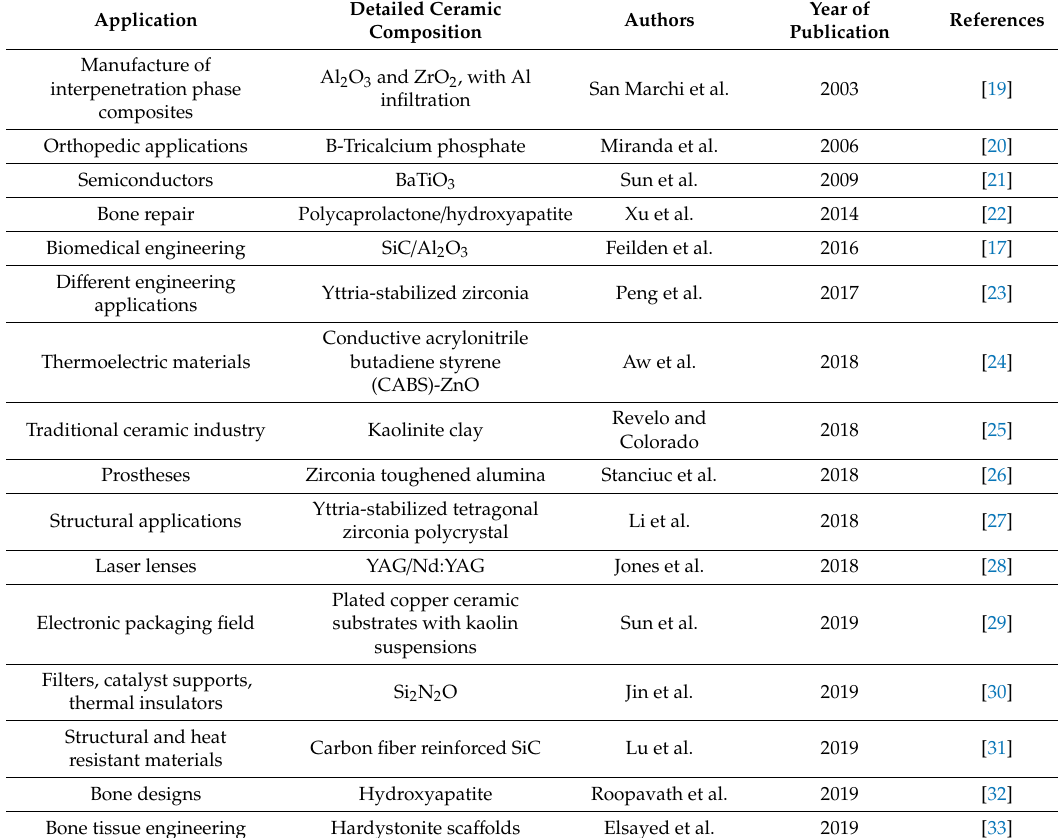
Table 1. A summary of recent research on direct ink writing (DIW)-printed ceramic